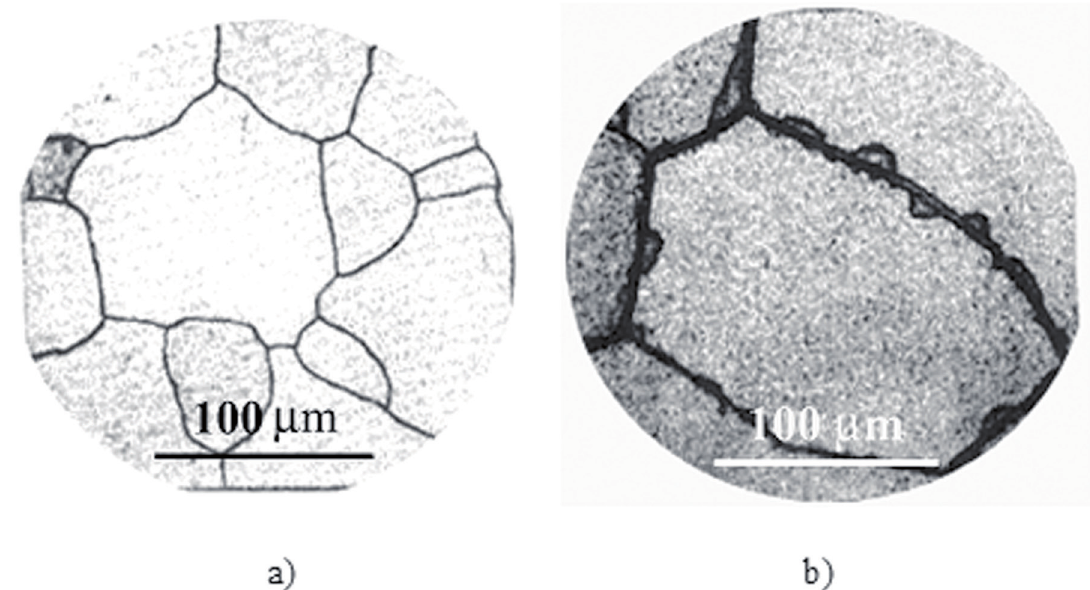
Figure 1: The microstructure of the sample PtRh20Pd10Ir0.1Au0.1 with total content of the impurities a) 0.015 % (wt.), 70x ; b) 0.083% (wt.), (magnification 200x)